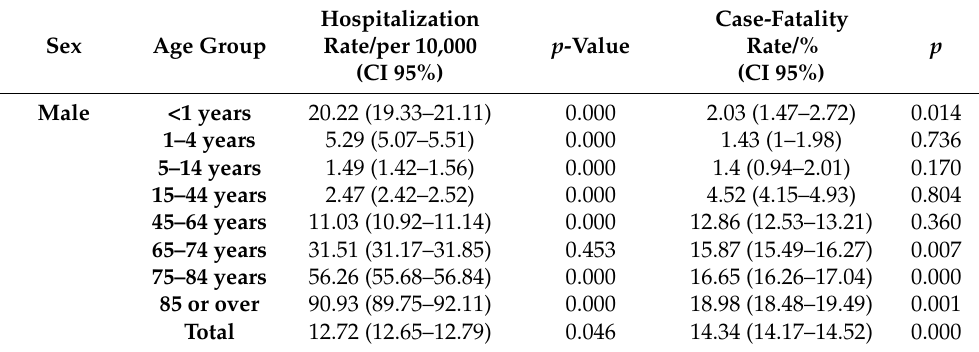
Table 1. Hospitalization rate and case-fatality rate by sex and age group due to pneumococcal infection in Spain